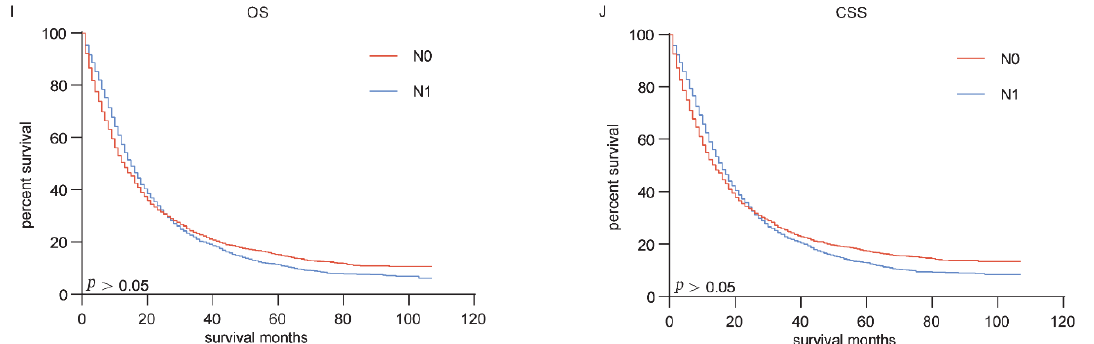
Figure 5. Kaplan-Meier survival curves for PDAC patients. ( A , B ) Effects of distant metastasis on OS and CSS. ( C , D ) Effects of age on OS and CSS. ( E , F ) Effects of primary site on OS and CSS. ( G , H ) Effects of grade on OS and CSS. ( I , J ) Effects of lymph node status on OS and CSS. OS, Overall survival; CSS, cancer specific